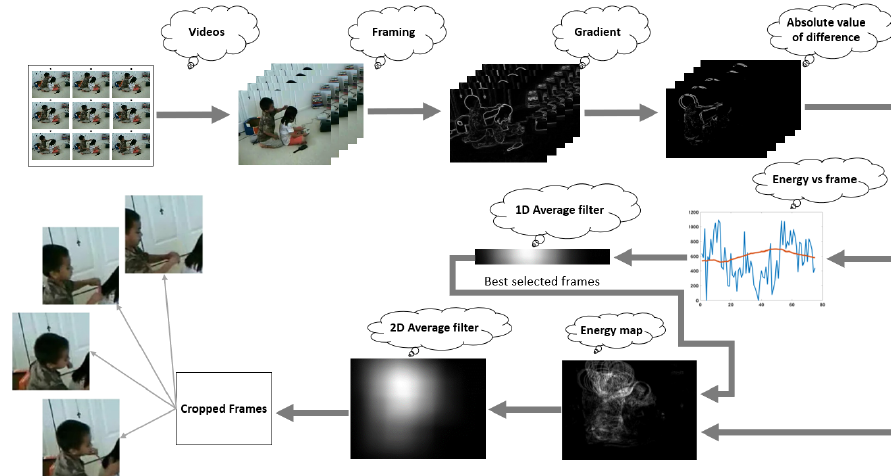
Figure 1. Flowchart of the proposed